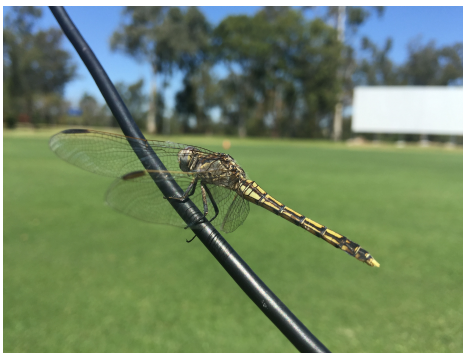
Figure 1. A dragonfly that has landed on a cable, demonstrating the impressive visual guidance of insects, despite their small brains and restricted computational